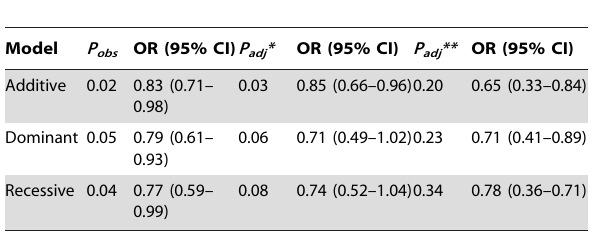
Table 4. Comparison of three genetic models of inheritance for MLXIP polymorphism rs4758685 associated with